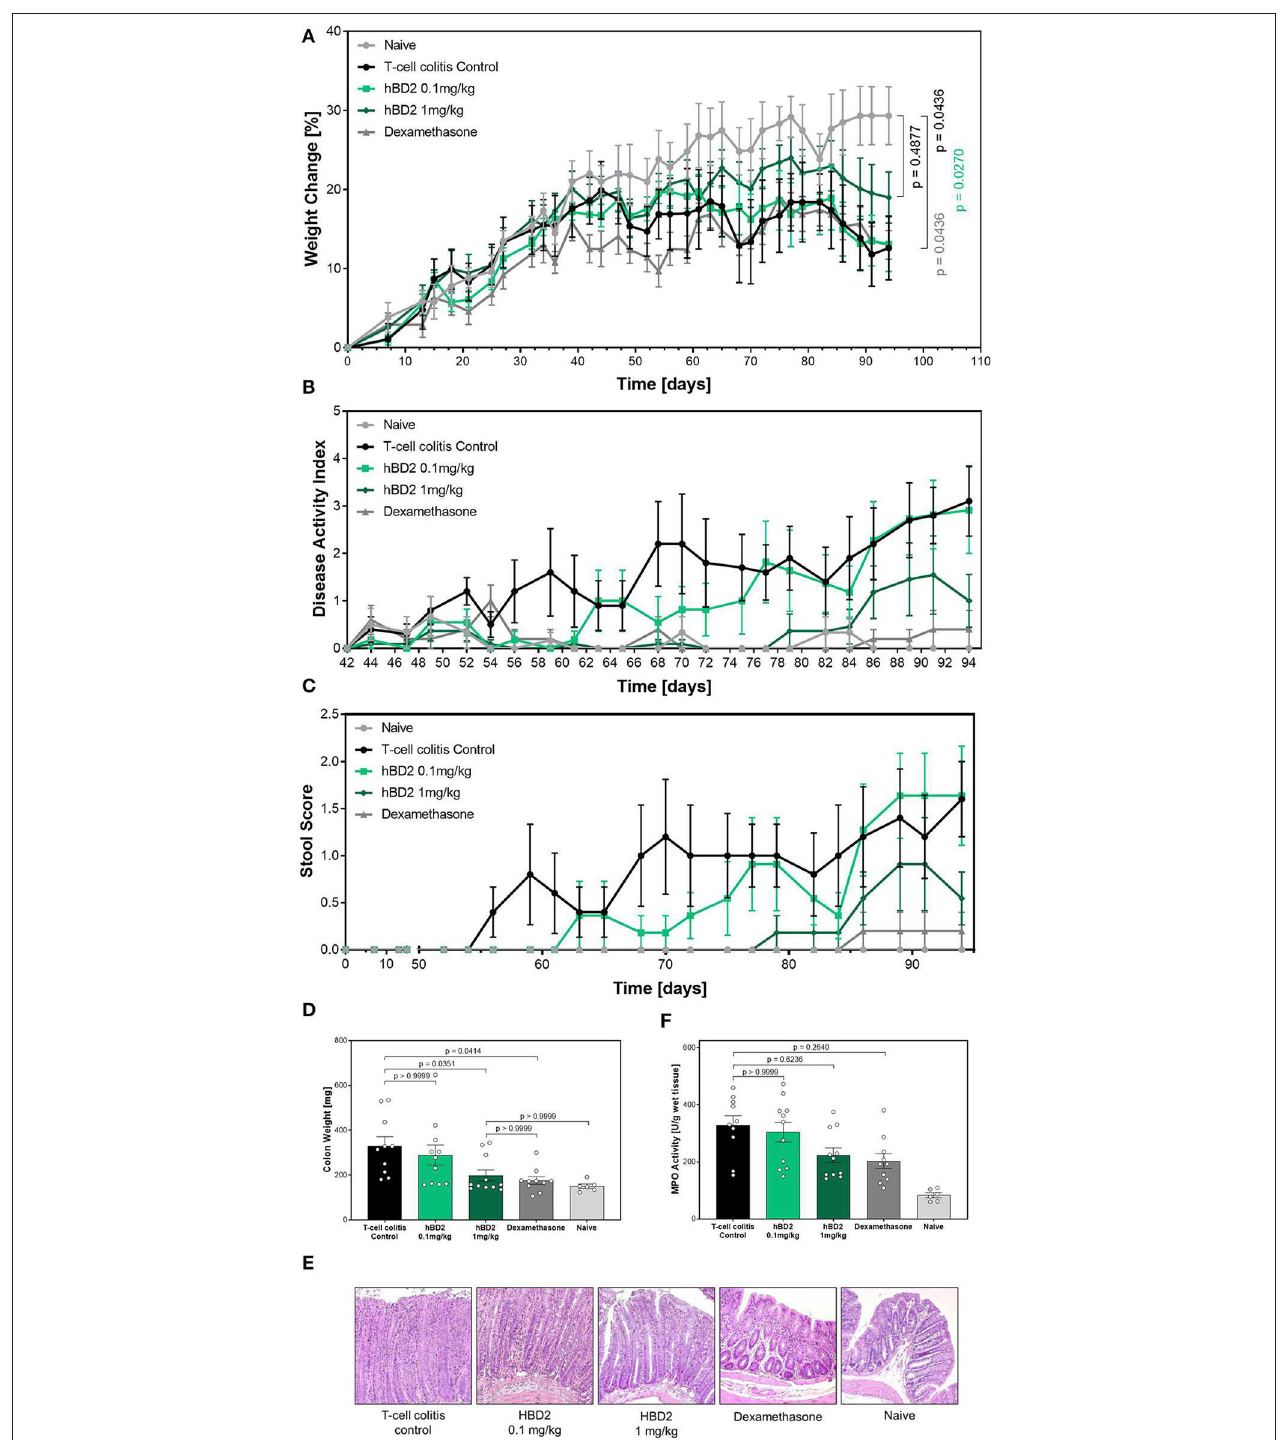
FIGURE 7 | Protective effect of hBD2 in T cell transfer colitis. Colitis was induced by transferring CD4 + /CD25 − T cells from WT mice to SCID mice. Development of colitis was observed for 94 days. Daily treatment with hBD2 (0.1 mg/kg or 1 mg/kg, s.c.) and Dexamethasone (0.3 mg/kg, i.p.) started 7 days after the transfer. (A) Weight change of mice during the experiment was monitored as well as (B) development of clinical symptoms as DAI. (C) Alteration of stool consistency was assessed as stool score. At the end of the experiment (D) colon weight was measured and (E) activity of myeloperoxidase (MPO) was quantified. (F) Representative images from the colon of differentially treated mice are shown. Results are presented as mean ± SEM, n = 6 (sham treated animals), n = 10 (vehicle and dexamethasone mice) and n = 11 (hBD2 mice). Appropriate statistical comparisons are shown within the graph by a Kruskal-Wallis-test for non-parametric data with a Dunn’s